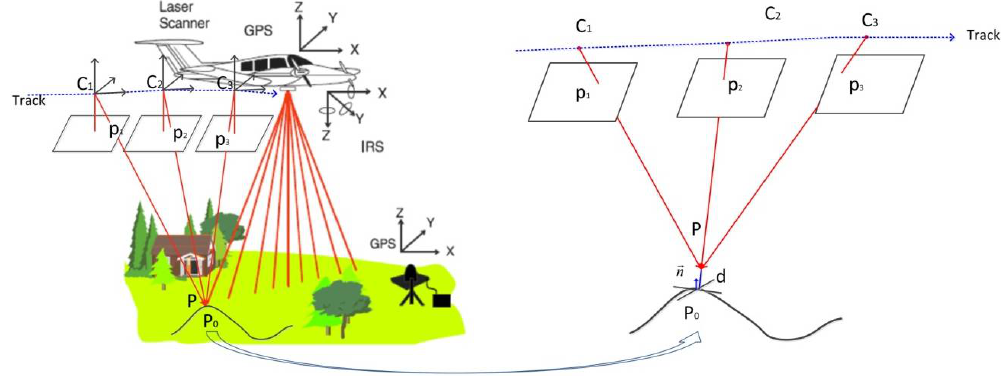
Figure 1. Fundamental geometric relationship between aerial optical images and LiDAR data.